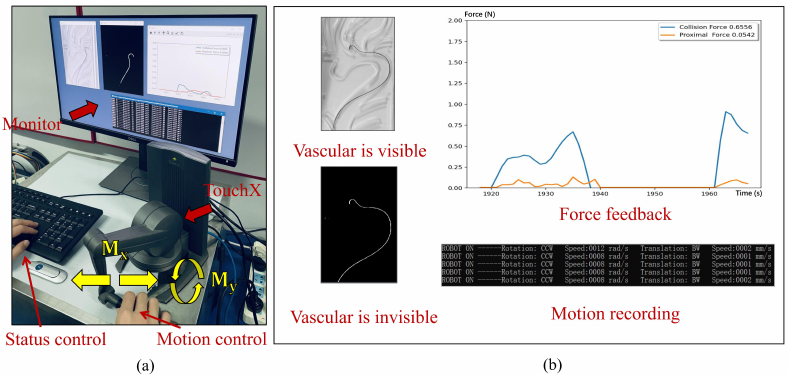
Figure 4. The master controller and force feedback. ( a ) Master end. ( b ) Real-time surgical